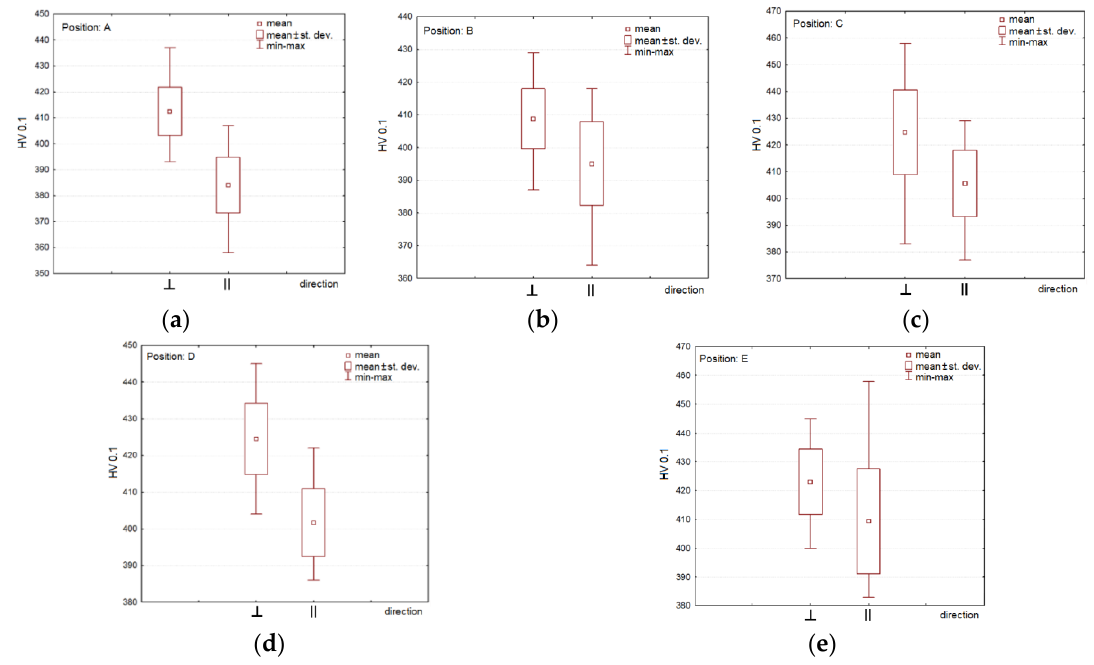
Figure 7. Comparison of hardness characteristics for two directions in each position on the build platform: ( a ) position A, ( b ) position B, ( c ) position C, ( d ) position D, ( e ) position E.